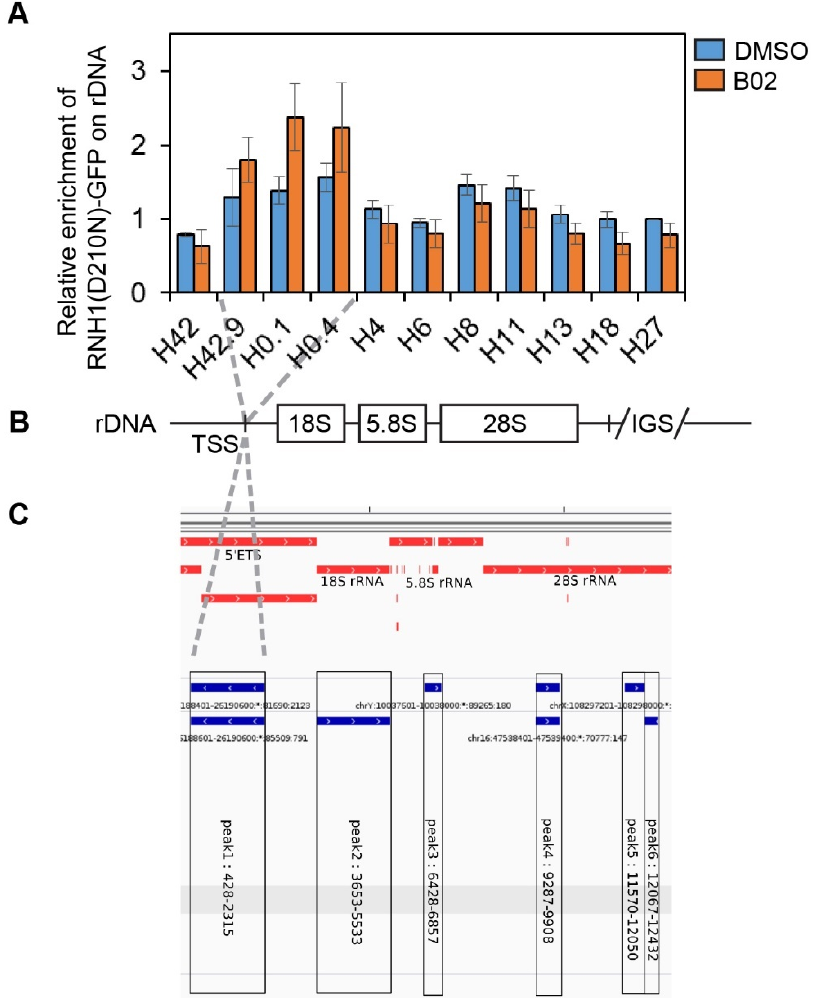
Figure 5. R-loops accumulate around the rDNA transcription start site upon B02 treatment. ( A ) U-2-OS T-REx (RNH1(D210N)-GFP) cells were treated with doxycycline (1 ng/mL) for 24 h simultaneously with nocodazole (100 ng/mL) for the last 20 h and with or without B02 (20 µ M) for 3 h post-release from cell cycle arrest. After pre-extraction and fixation, the cells were subjected to chromatin immunoprecipitation of RNH1(D210N)-GFP-bound regions followed by quantitative PCR analysis (qPCR). The data were analyzed by taking the cycle threshold values from a qPCR assay. Relative enrichment was calculated and normalized to the amplicon H27 of non-treated sample. The data plotted are pooled from 3 experiments. ( B ) Schematic representation of primer alignment to the rDNA locus. ( C ) Print-screen from the Integrative Genomics Viewer (IGV) browser for human rDNA (acquired in July 2017) presenting localization of the replication origins within the ribosomal DNA locus (blue lines).